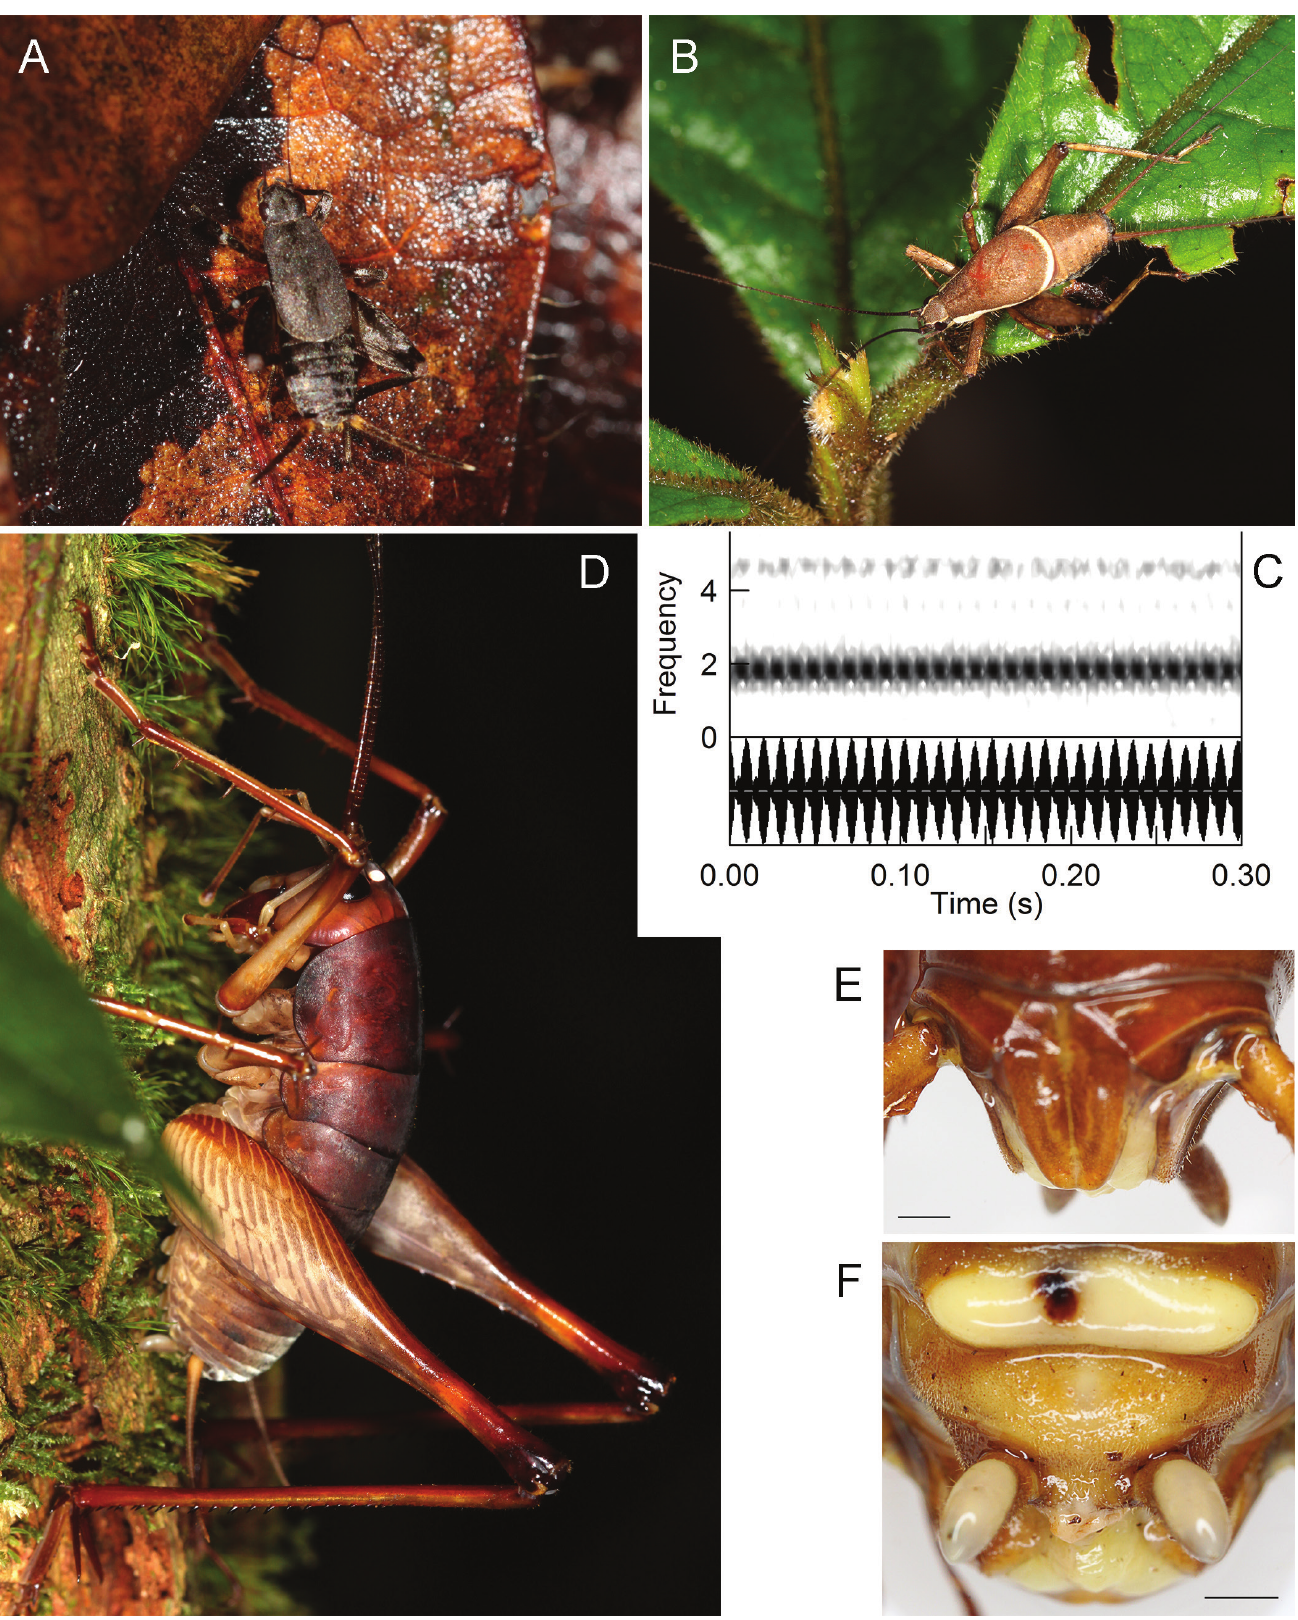
Fig. 12. Mogoplistidae, Gryllotalpidae, and Rhaphidophoridae: A. Cycloptiloides sp.; B. Ectatoderus cf. angusticollis ; C. Gryllotalpa (?) sp. (frequency in kHz); D. Rhaphidophora (?) sp. male; E, F. Male abdominal apex. Scale bars: